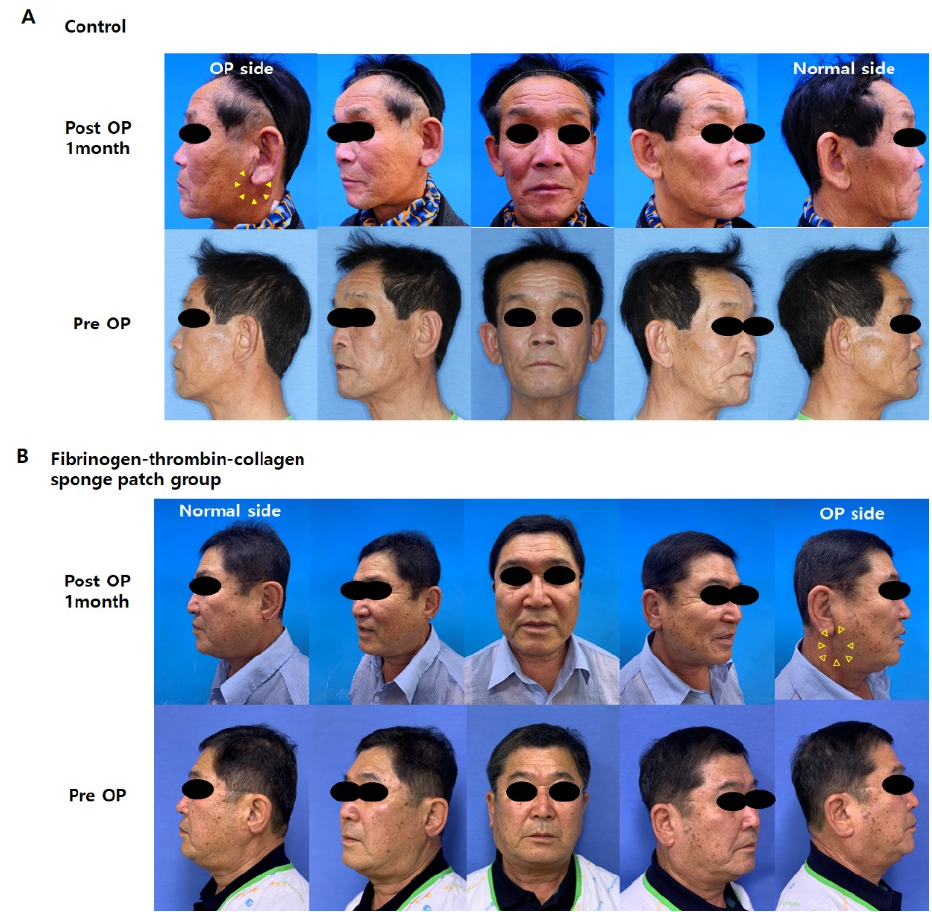
Figure 4. Representative facial photo images of the enrolled patients at pre- and post-operative 1 month. ( A ) Control group. A 74-year-old male underwent left superficial parotidectomy (pleo- morphic adenoma, 2.6 cm × 1.9 cm × 1.9 cm). A fibrinogen-thrombin-collagen sponge patch was not applied in the surgery. The picture shows mild depression (arrowhead) on the operation site compared to normal side at 1 month after surgery. ( B ) A 55-year-old male underwent right superficial parotidectomy (pleomorphic adenoma, 3.7 cm × 2.0 cm × 1.8 cm). A fibrinogen-thrombin-collagen sponge patch (4.8 cm × 4.8 cm) was applied on the resected plane. The follow-up photo at 1 month shows good cosmetic results on the operation site (open